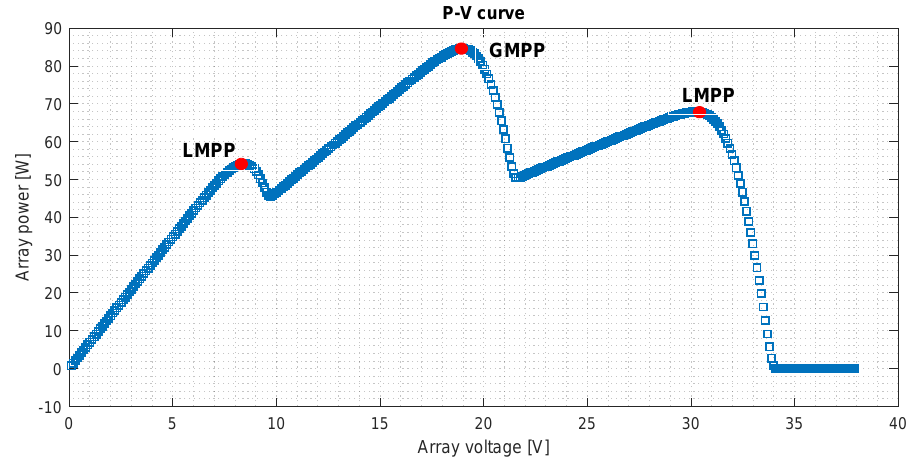
Figure 10. P-V curve for a PVM with three submodules.